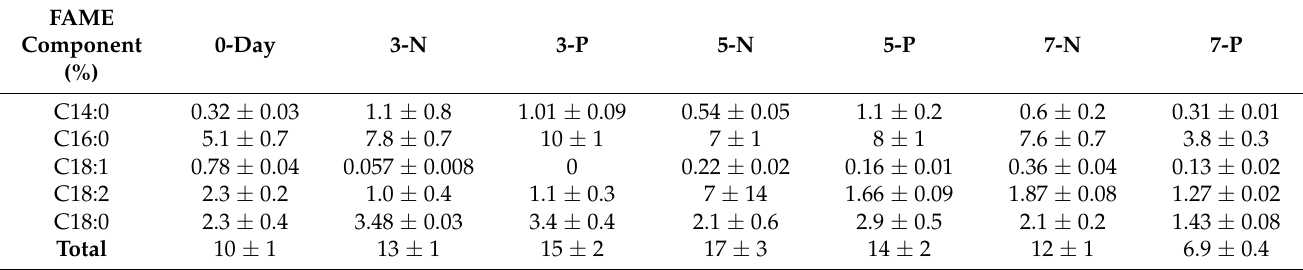
Table 7. Fatty acid methyl ester (FAME) composition of Chlorella sorokiniana 2 isolated from Knop’s medium, pH-9 in nutrient-amended media. (3, 5, and 7 denote the culture time in days, and N and P represent the N-amended medium and P-amended medium,